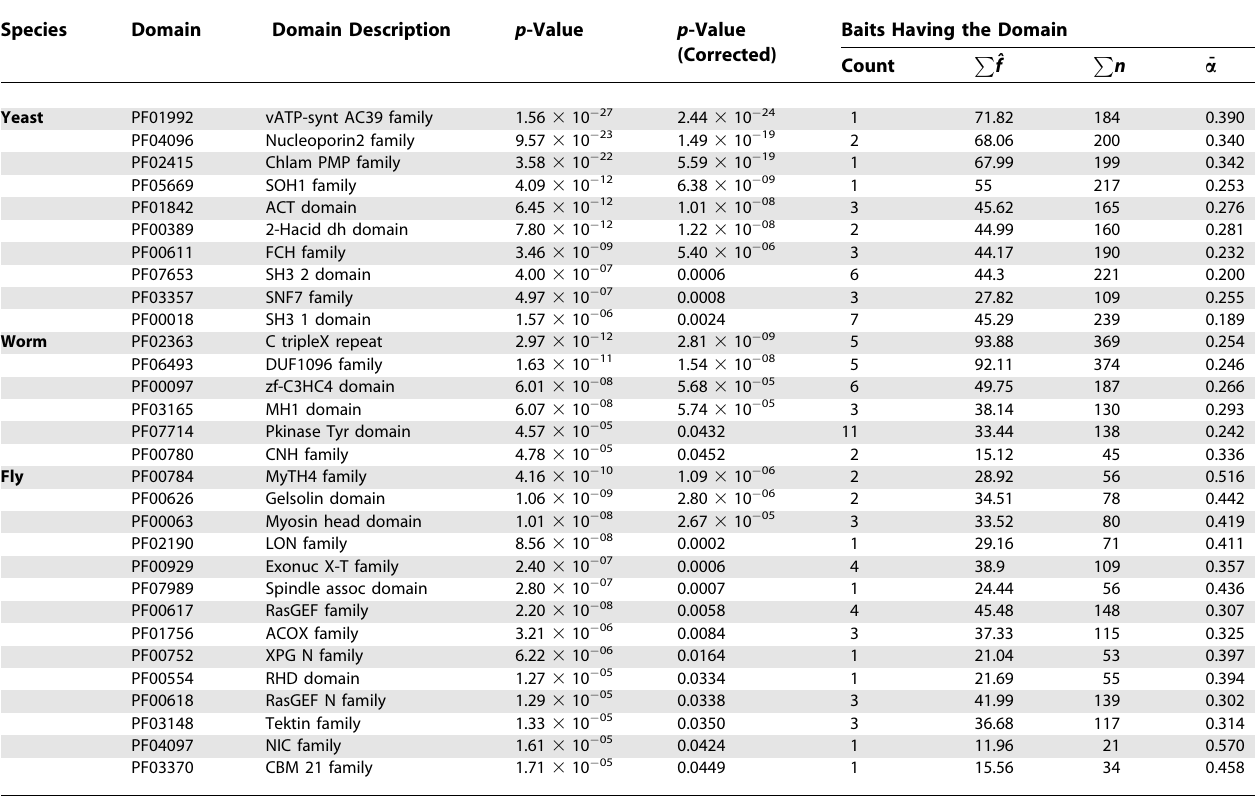
Table 4. Promiscuous Domains